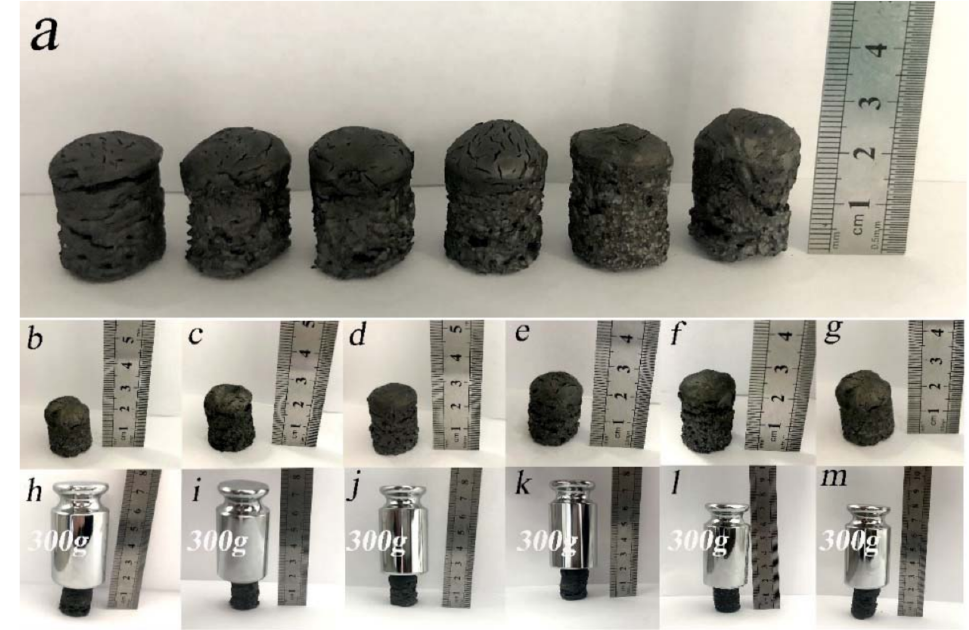
Figure 6. Compression test pictures of GA aerogel and GA-MCC (1–5) aerogel. ( a ) Six groups of aerogel samples. ( b – g ) GA aerogel and GA-MCC (1–5) aerogel. ( h – m ) GA aerogel and GA-MCC (1–5) aerogel subjected to a mass pressure of 300